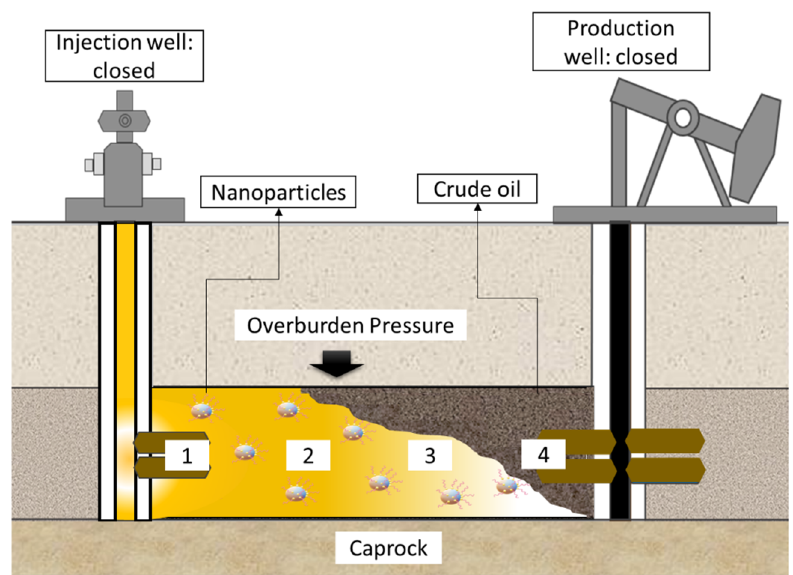
Figure 8. Schematic representation of considered scenario for hydrogen fugacity analysis. The system considers the following assumptions: injection and production well are closed (the ∆ P on the x -axis is neglected); the overburden pressures for HO1 and HO2 were 1582 and 1992 psi, respectively; the density of the rock matrix for the two reservoirs was 2.55 g·cm − 3 (sand rock); the depths of the reservoirs were HO1 = 1600 ft, HO2 = 2000 ft; white boxes assume different temperatures based on displacement tests;and presence of caprock below the reservoir.